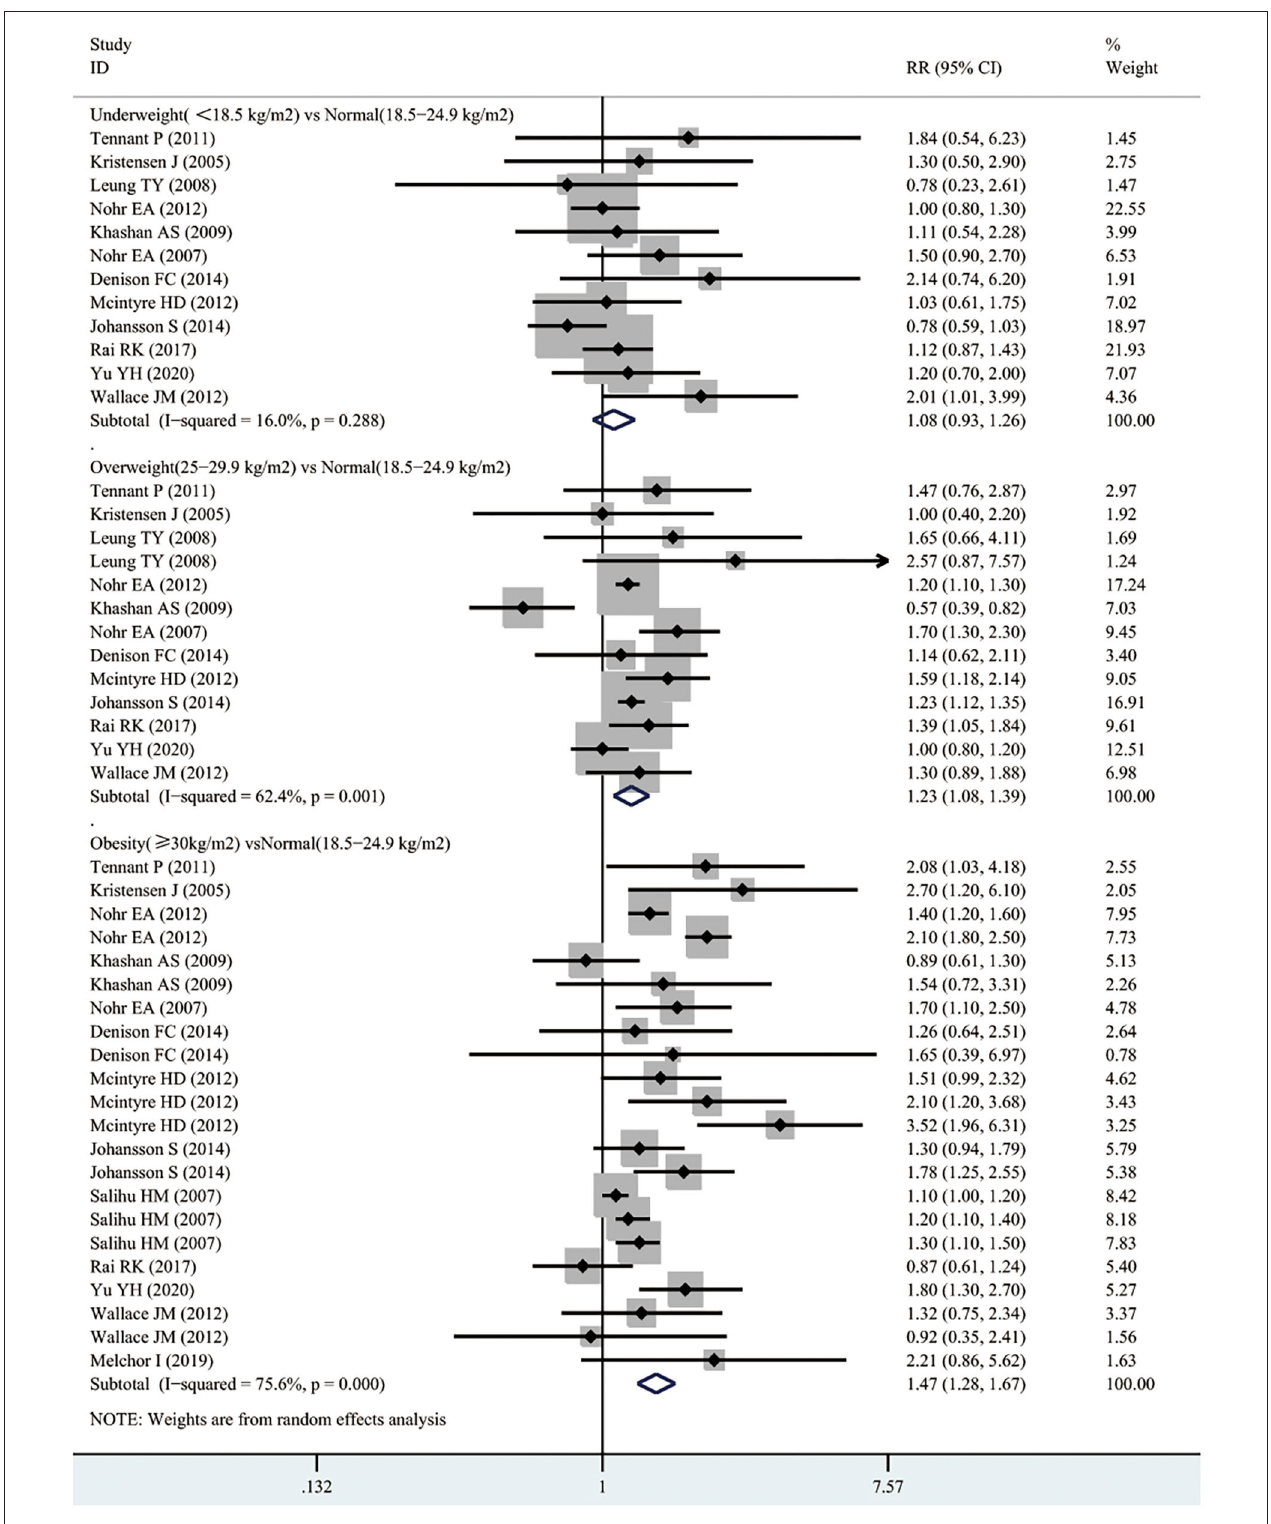
FIGURE 4 | Forest plots of maternal BMI and the risk of neonatal mortality.